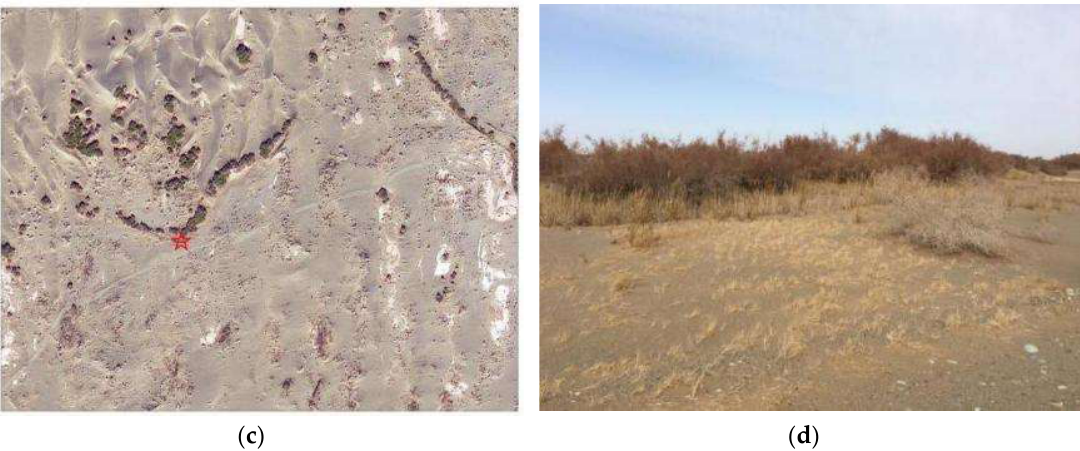
Figure 7. Extracted dried-up watercourse of the source of Shangbanao Spring and a field photo of the upstream area. ( a ) The extracted drainage network overlaid on the shaded relief model; ( b ) the extracted drainage network overlaid on the Gaofen-2 image; ( c ) traces of the river flow with red willows on the Gaofen-2 image; ( d ) field photo of red willows and reeds at the star location in ( c ). Therefore, Shangbanao Spring is only the surface headstream of the Dagou, and the extracted dried-up watercourse shows that the groundwater sources trace far away to the southeast and are assumed to belong to the theorized northern border of the mysterious Daze range present during the Tang Dynasty (618–907 A.D.). Records indicate that the Daze range was 7 tangli (1918.6 m) south of Shouchang City and extended 10 tangli (5598 m) from east to west and 15 tangli (8397 m)